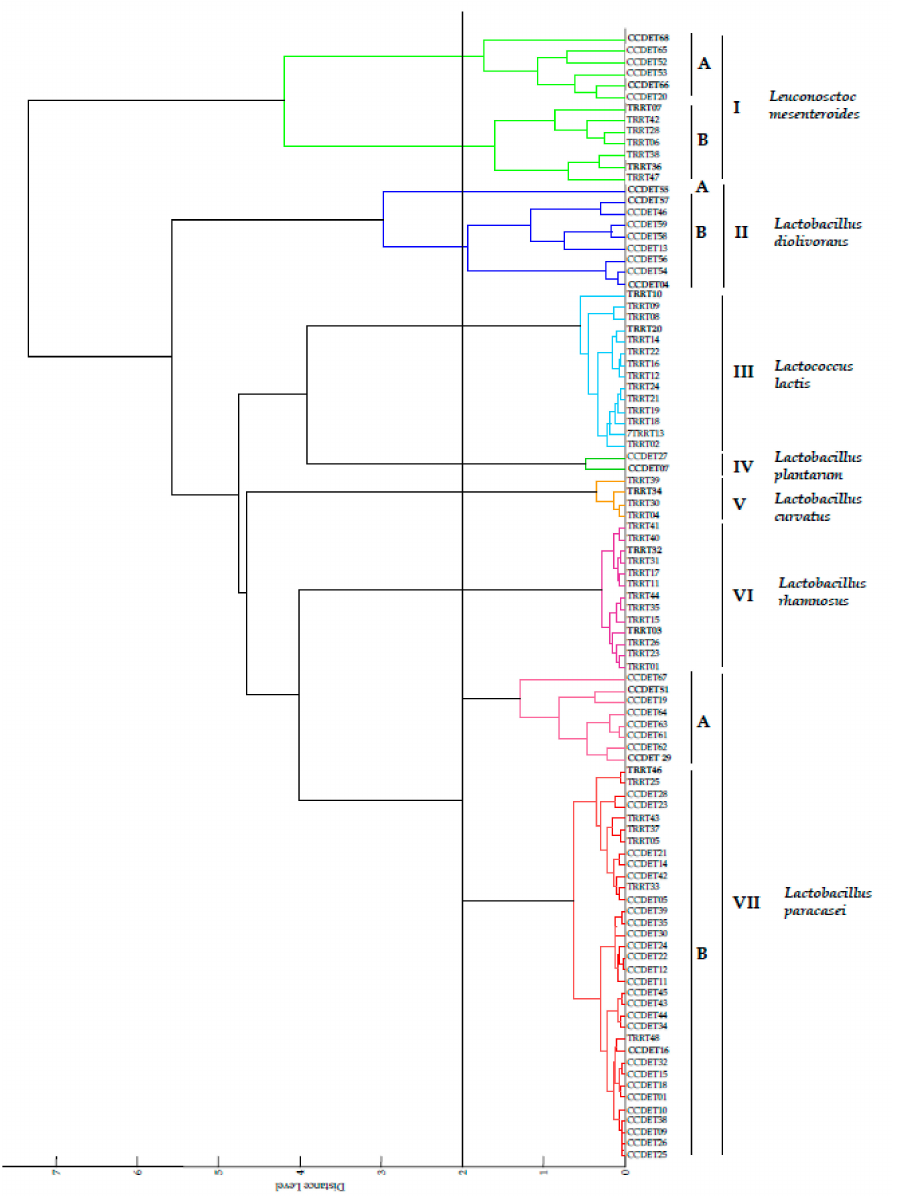
Figure 1. Cluster analysis of MALDI-TOF MS spectra of strains isolated in this study. Distance is displayed in relative units. Representative strains of each group selected for pheS gene analysis are marked in